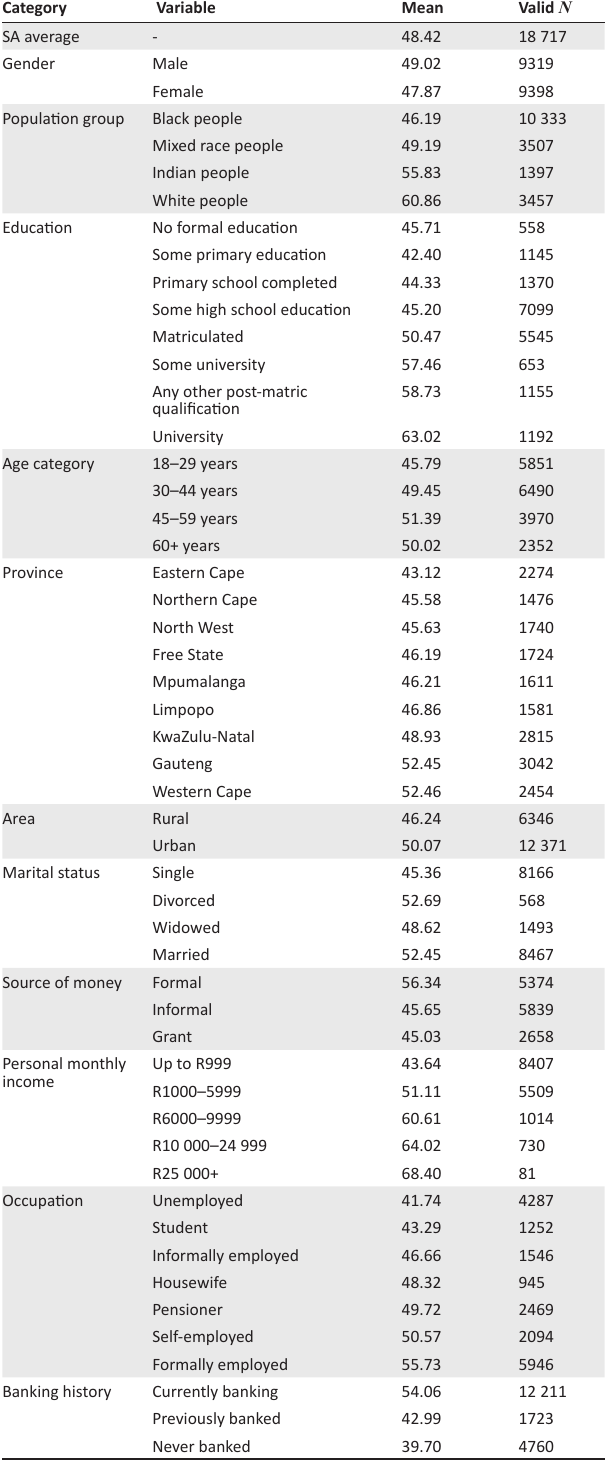
TABLE 1-A5: Decomposition of average scores of financial literacy.